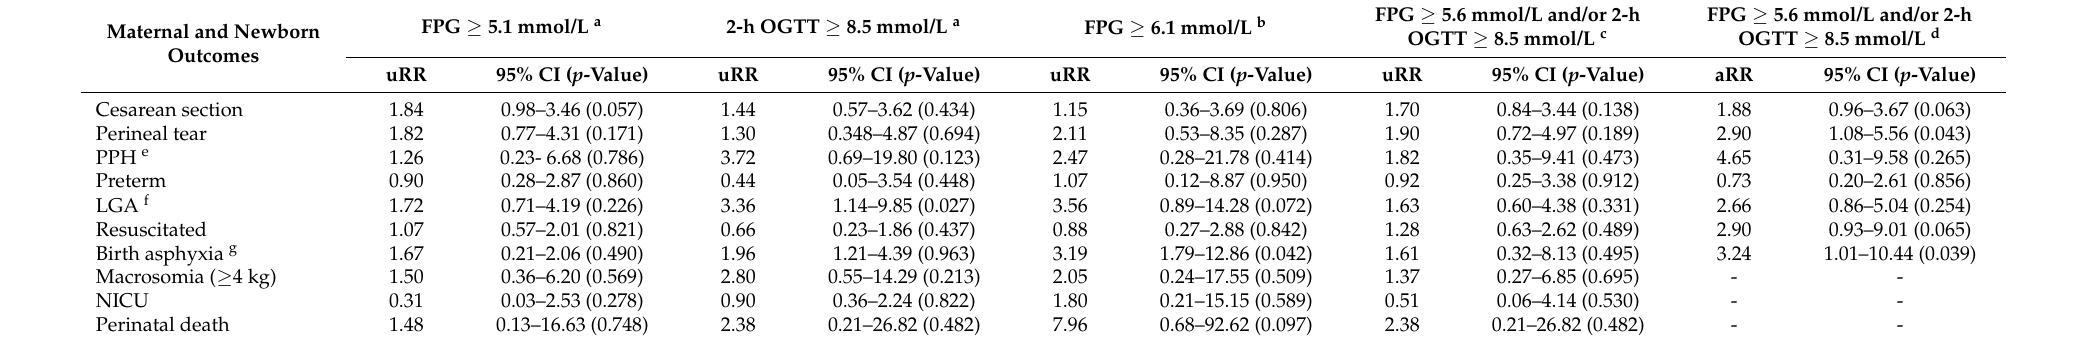
Table 5. Relative risk for adverse pregnancy outcomes associated with GDM using different diagnostic